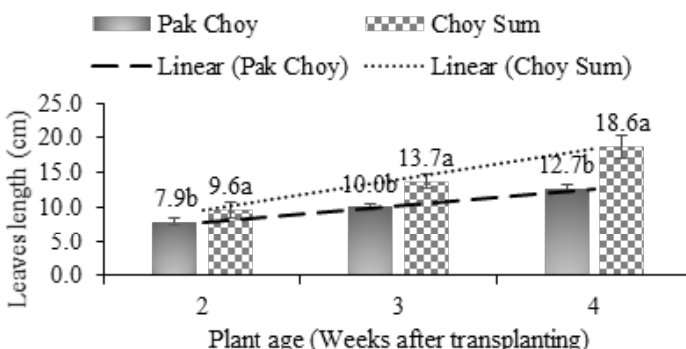
Figure 4 Leaves length on 2 subspecies Brassica during plant growth. Values followed by the same letter in the same age are not significantly different (p < 0.05) by Duncan's multiple range test at Table 7. Effect of initial electrical conductivity on plant height, number of leaves, leaves length, and leaves